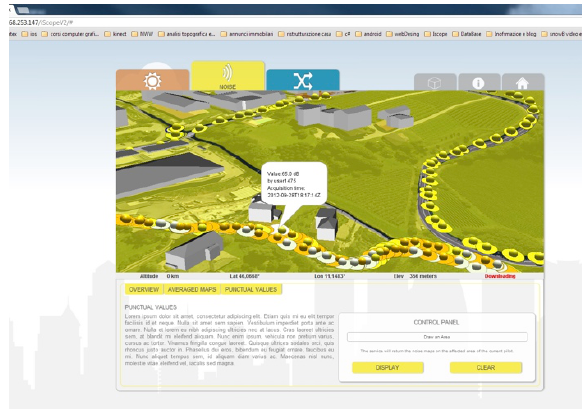
Figure 4: The web client application. The 3D buildings are shown together with a service providing the noise measured by the citizen through mobile phone. The panel on the web page is used to perform the requests and visualise the retrieved